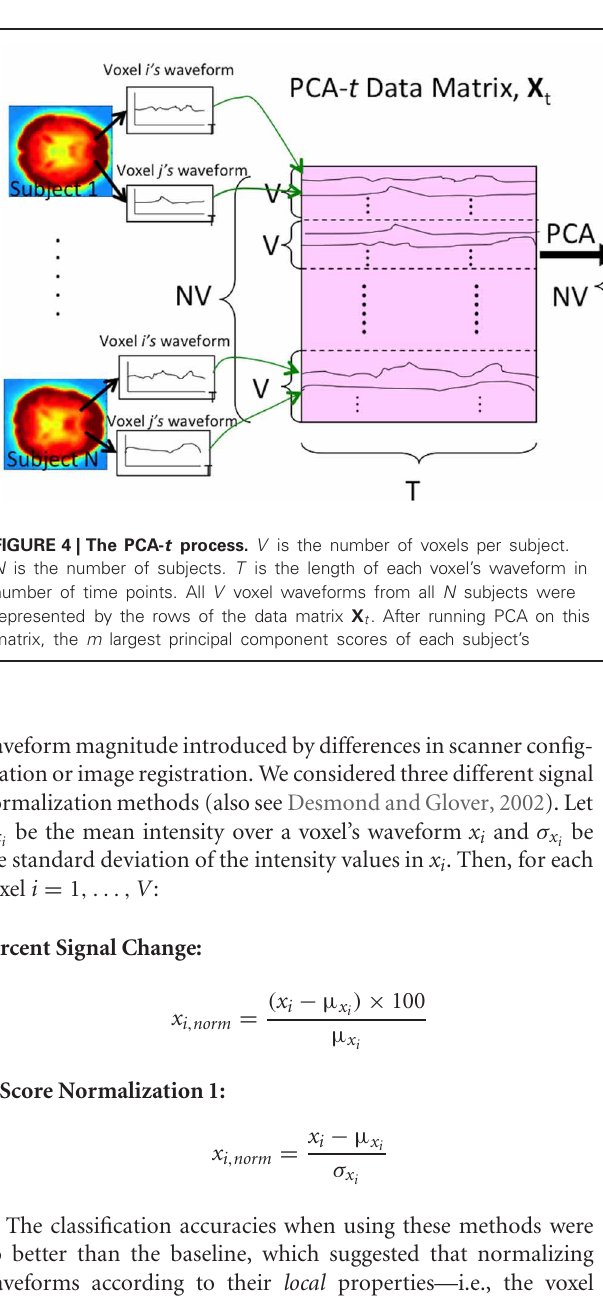
waveforms were used as the reduced-dimension features. Note that the input signal was always the 3 × 3 × 3 averaged (spatially-reduced) version within the masked sub-volume. For some tests ( Figure 2 ), the “waveform” used to form the PCA- t matrix was the FFT of the original waveforms (see section